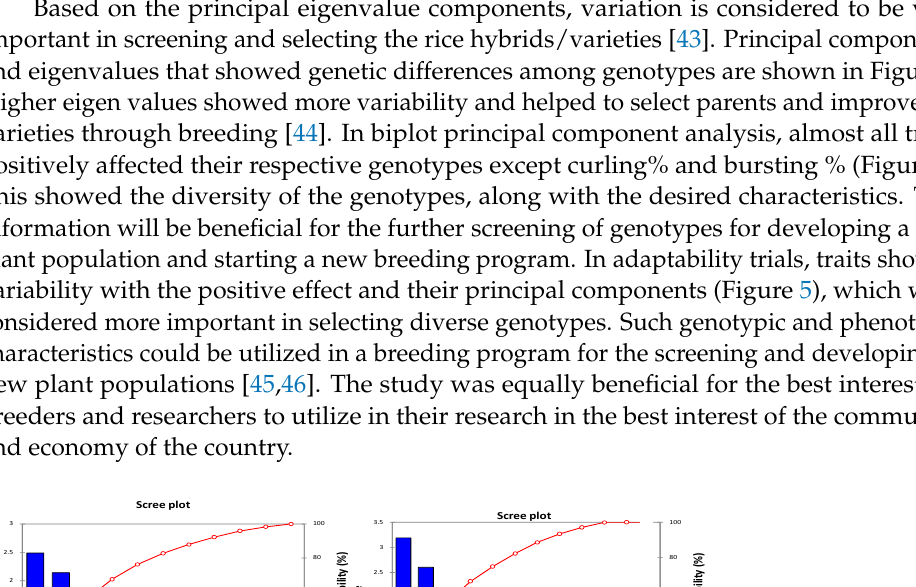
Figure 3. Scree plot of principal component analysis rice hybrids between their eigen values, number of principal component and accumulative variability% under adaptability trials 2020-2021.